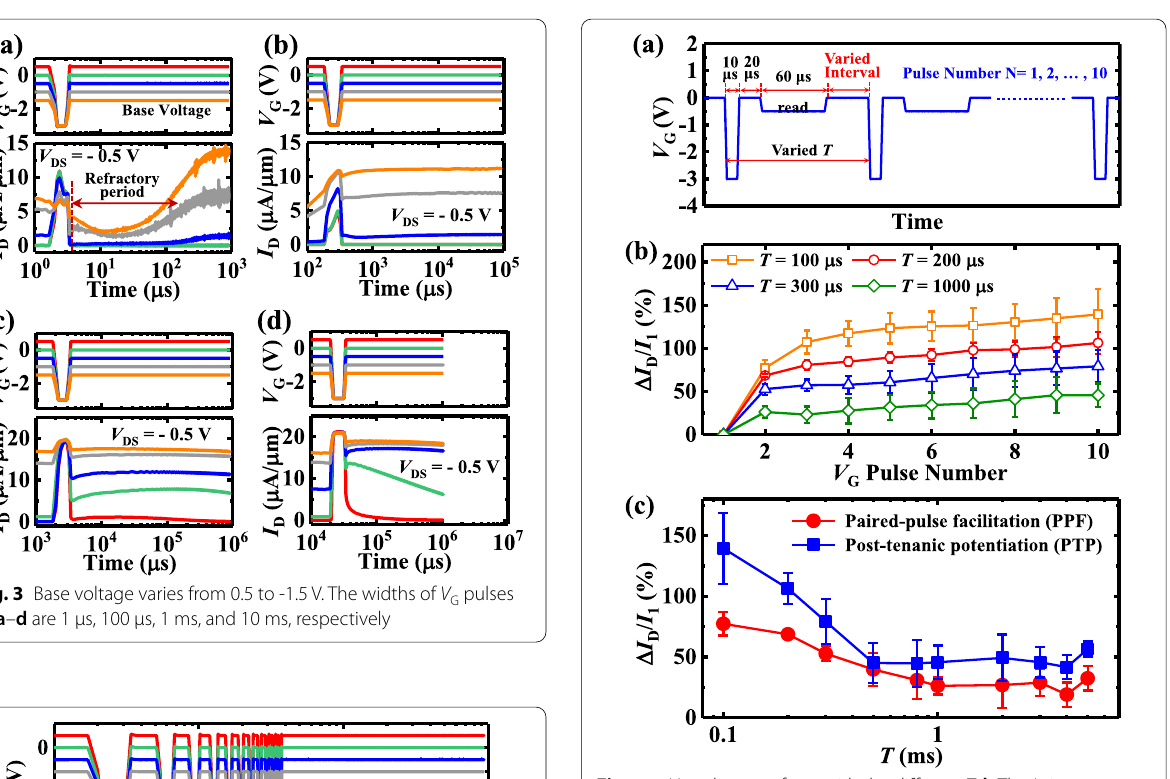
Fig. 5 a V G pulse waveform with the different T . b The I D increase as a function of the gate stimulus number plots with the different T . c Extracted ( I 2 I 1 )/ I 1 and ( I 10 I 1 )/ I 1 , representing PPF and PTP − − behaviors, respectively, of the